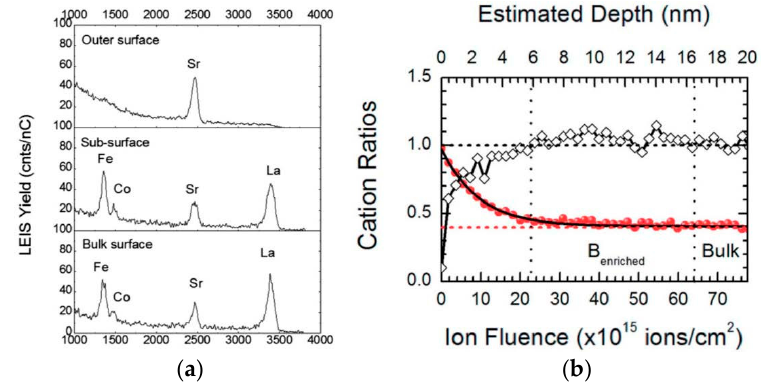
Figure 11. LEIS measurements with 20 Ne + primary beam at 6 keV at different depths of an LSCF ceramic annealed for 12 h at 1273 K. ( a ) Selected partial spectra corresponding to the very outer surface, the sub-surface and “bulk” regions; ( b ) Depth profile of Sr site fraction (solid circles) and B:A cation ratio (open diamonds). Reproduced from [98] by Druce et al. with permission of The Royal Society of Chemistry.